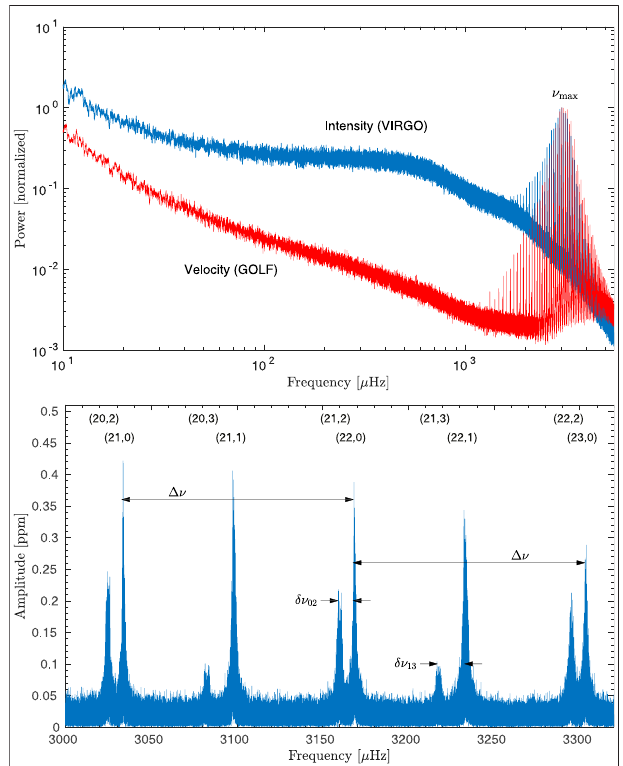
FIGURE 1 | Top panel: Solar power spectra computed from almost 20 years of data from the VIRGO and GOLF instruments on board the SOHO satellite. The VIRGO observations are from the green channel at 500 nm. The power spectra have been smoothed by a boxcar function of 0 . 17 μ Hz width, and are normalized such that the amplitudes are equal near the frequency of maximum amplitude of the acoustic modes ] max ≈ 3100 μ Hz. Bottom panel: Amplitude spectrum computed from the VIRGO photometric data near ] max (note the non-logarithmic scale). The peaks are labeled by their radial order n and angular degree ℓ as ( n , ℓ ) . A few characteristic large and small frequency spacing examples are labeled with Δ ] and δ ] ,